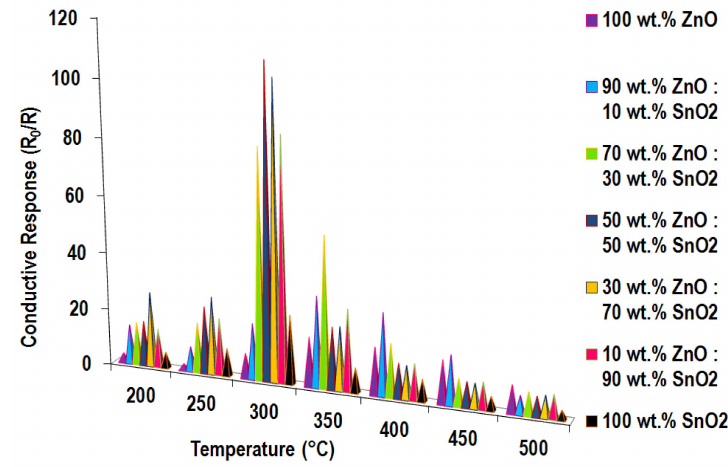
Figure 6. Conductive response of the SnO 2 -ZnO array against 100 ppm ethanol gas, as a function of increasing operating temperature. The best response of 110 is observed for the 50 wt% ZnO:50 wt% SnO 2 device at an operating temperature of 300 ˝